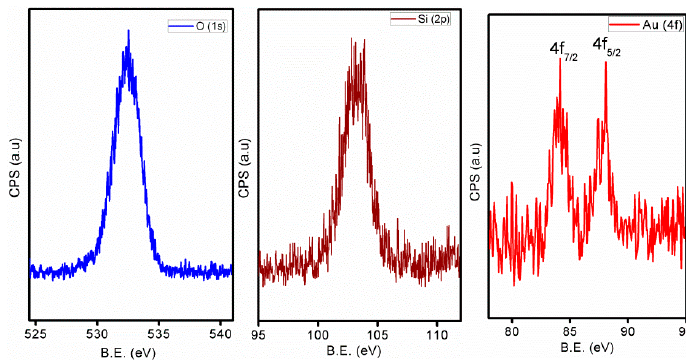
Figure 2. XPS data of the GSM-23F thin film after calcination.